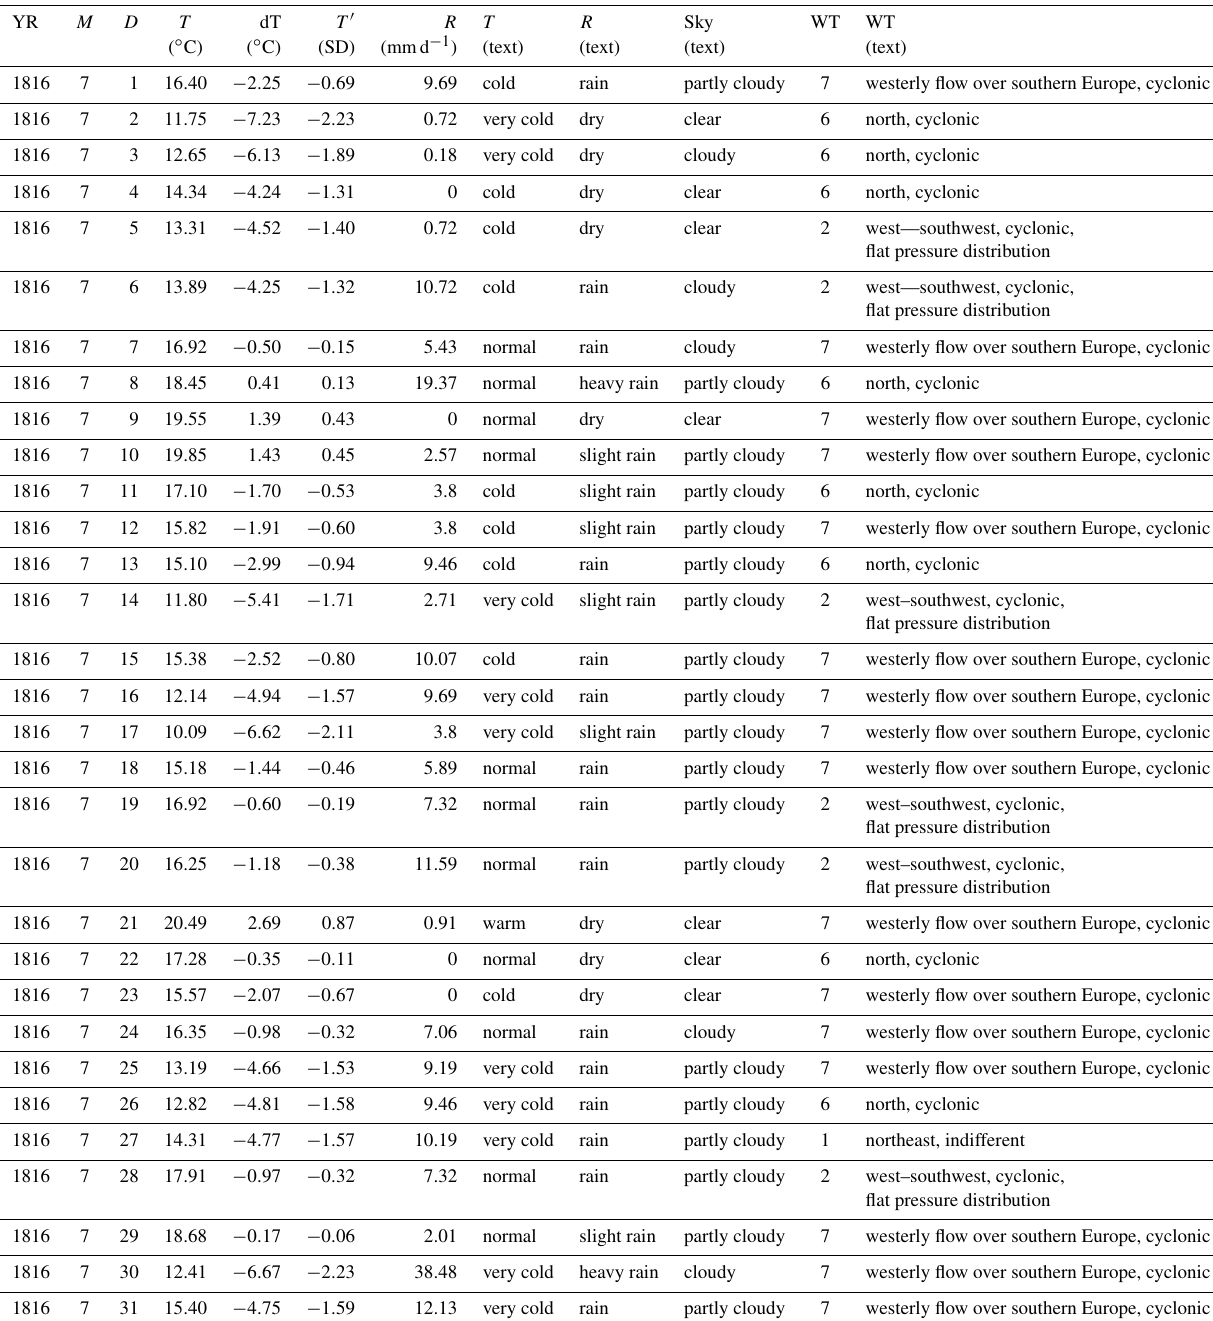
Table 4. Synthetic weather diary for Aarau, July 1816 (columns: YR: year; M : month; D : day; T : daily mean temperature; dT: daily mean temperature anomaly; T (cid:48) : standardised daily mean temperature anomaly; R : precipitation; the subsequent columns give text descriptions of temperature, precipitation, sky conditions, and weather type